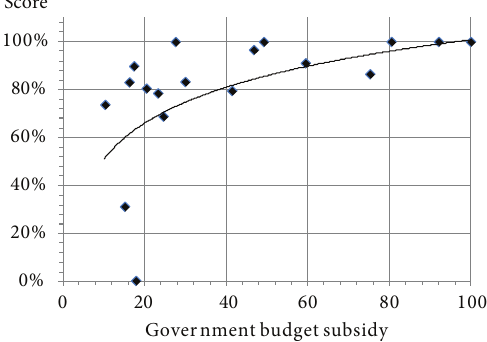
Fig. 4. Efficiency score versus university size Source: Calculated by the authors.